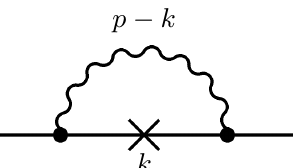
Figure 1. LO diagram to dynamically generated mass Σ ( p ) . The crossed line indicates a mass